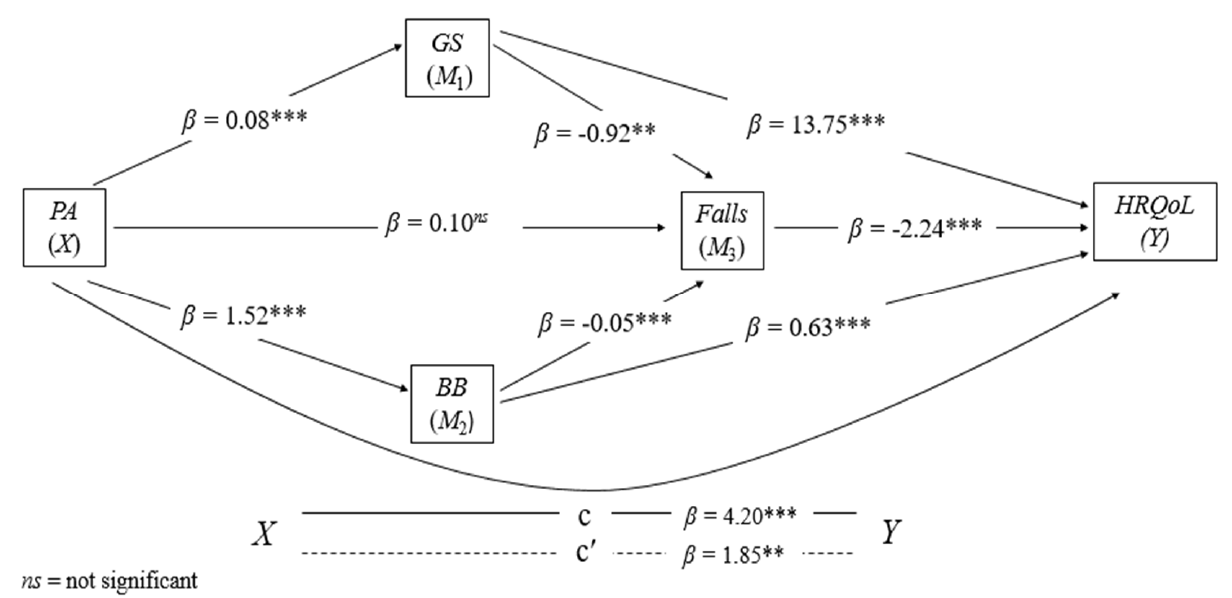
Figure 2. Results of the parallel–serial model of mediation of GS, BB and falls in the relationship between PA and HRQoL. The mediation hypothesis was tested by the bootstrap method with bias correction. Number of bootstrap samples = 5000. samples to calculate confidence intervals (95%), when the CI did not include 0 (zero). The products of the simultaneous regressions were presented by values of betas ( β ). X = PA: independent variable, Y = HRQoL: dependent variable.; ** p < 0.01; *** p < 0.001. Note: PA: physical activity; GS: gait speed; BB: body balance; HRQoL: health-related quality of life.